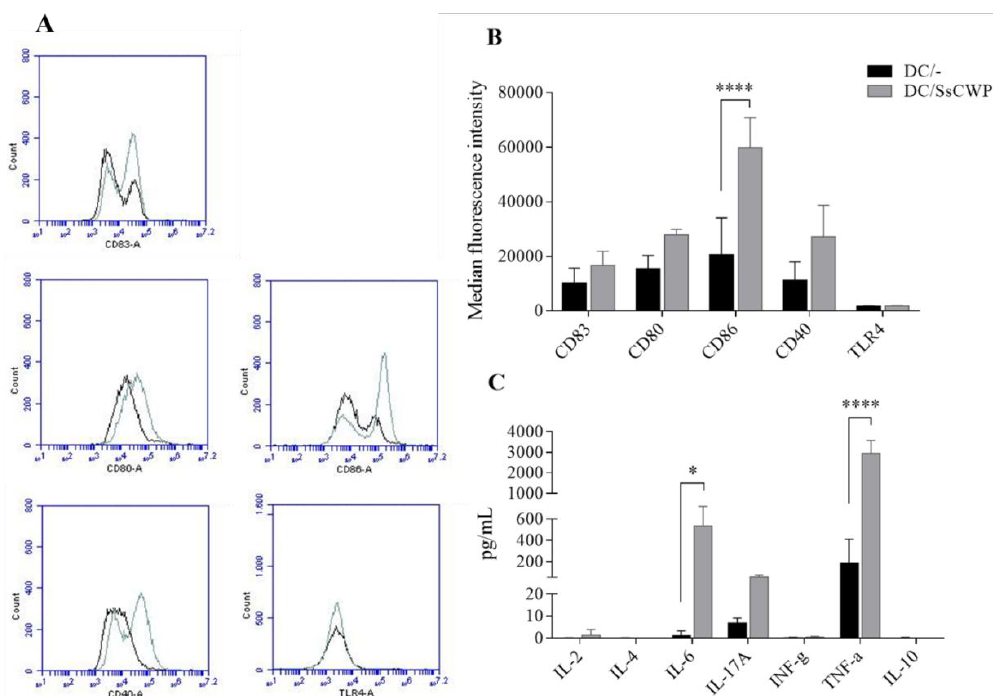
Figure 1. Phenotypical analysis of stimulated bone-marrow-derived dendritic cells (BMDCs). ( A ) Histograms representative of expression analysis of CD80, CD86, CD40, and TLR-4 (cellular activation markers) and CD83 (maturation marker) in BMDCs stimulated or not with SsCWP. ( B ) Cell surface expression of indicated markers on BMDCs. ( C ) Cytokine concentration in the culture supernatant of BMDCs. The data are presented as the mean ± SD of 3 three culture of pooled cells obtained from bone marrow of mice and the expression of markers are presented as their median fluorescence intensity (MFI). DC/-: unstimulated BMDCs (black line); DC/SsCWP: SsCWP-stimulated BMDCs (grey line). Asterisk indicates statistically significant difference between unstimulated and SsCWP-stimulated BMDCs: * (p < 0.05) and **** ( p < 0.0001) as indicated. DC: dendritic cell. SsCWP: Sporothrix schenckii cell wall